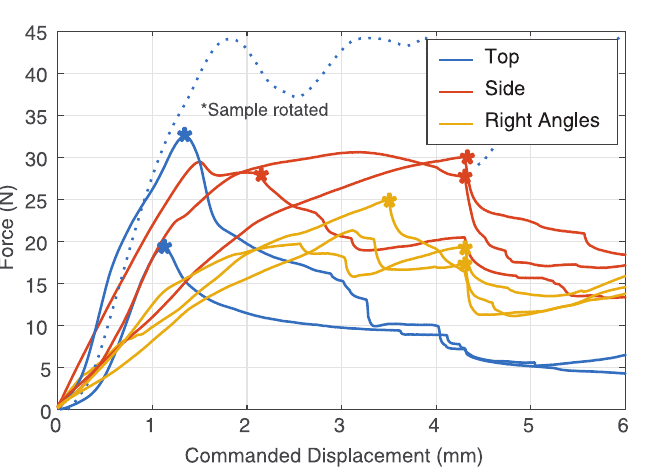
Fig 9. Specimen weights. Three samples of each type of specimen was weighed on a 0.01 gram resolution scale and averaged. The errorbars represent the standard deviation.